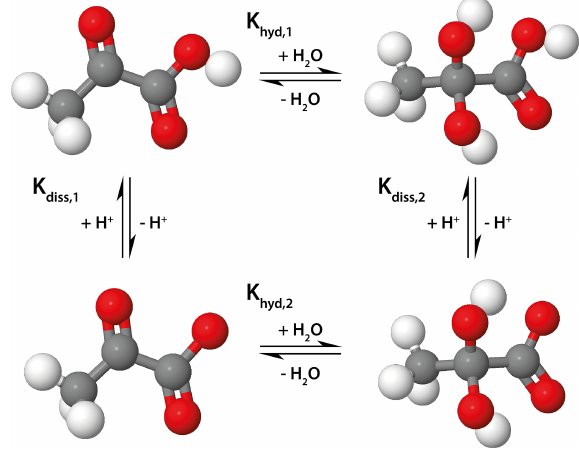
Figure 10. Scheme describing the four equilibria of pyruvic acid, a representative α -keto carboxylic acid, in aqueous